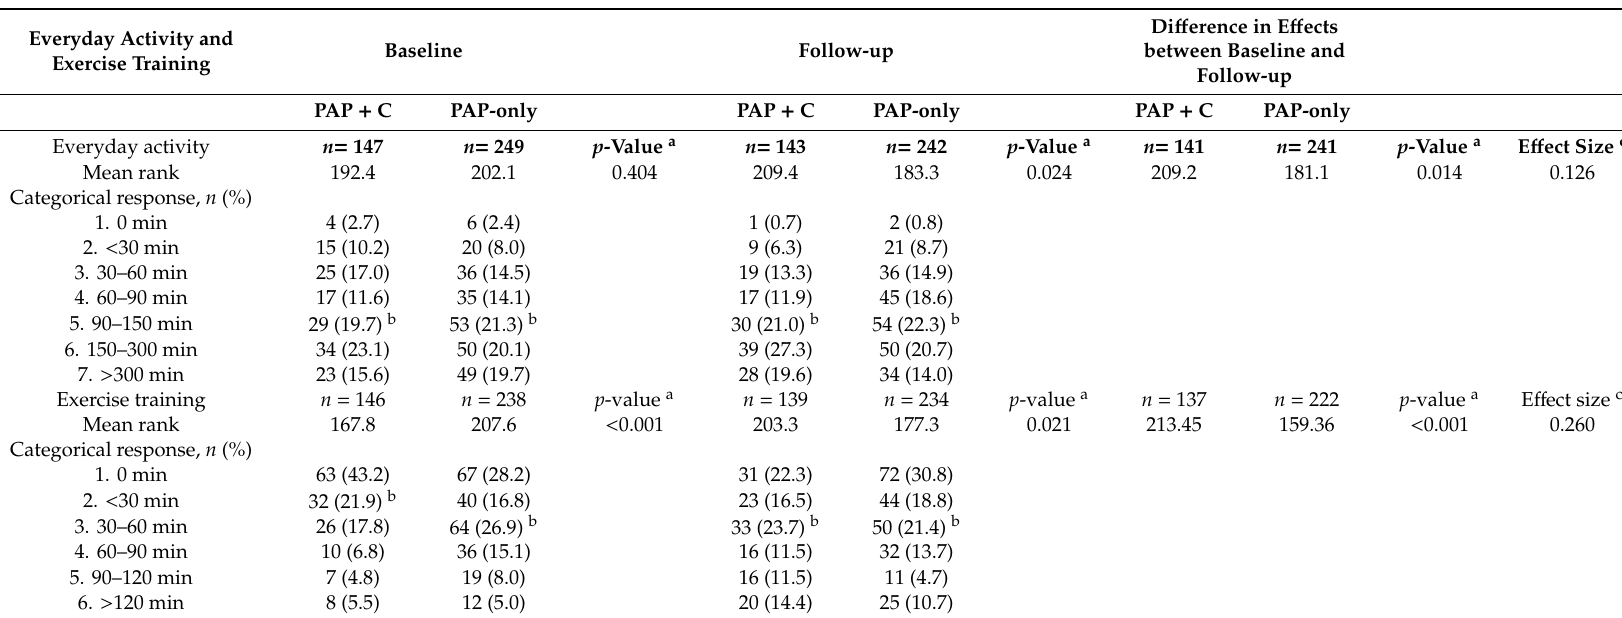
Di ff erence in E ff